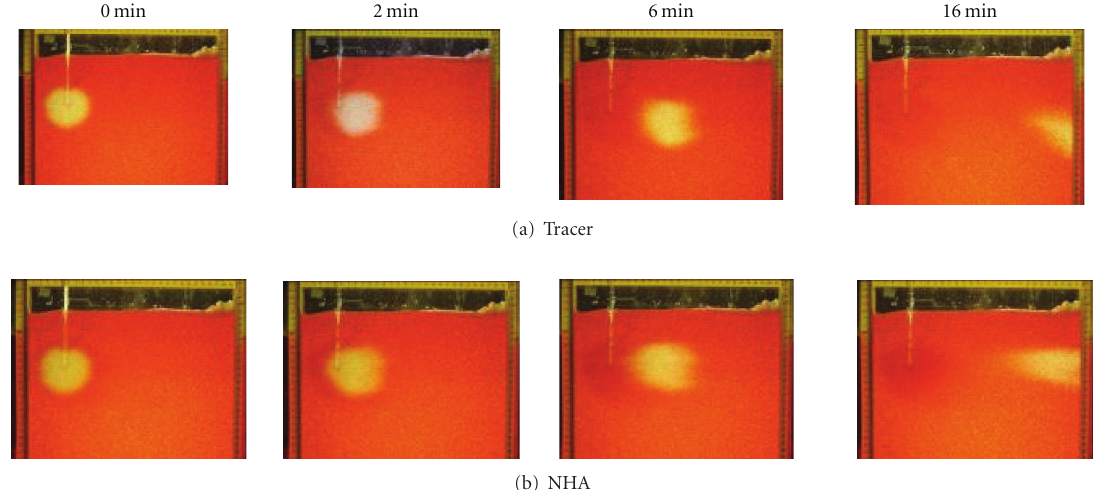
Figure 5: Transport of (a) tracer (uncolored deionized water) and (b) NHA plumes in the two-dimensional flow